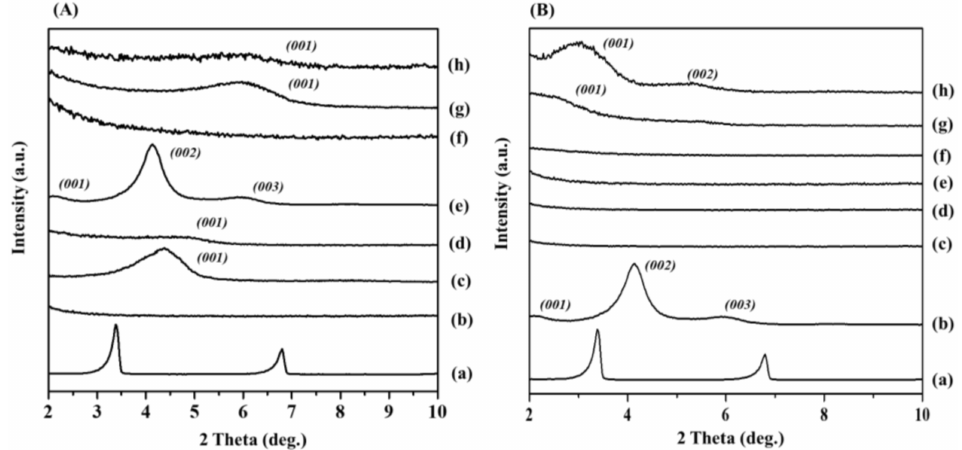
Figure 3. XRD patterns of: ( A ) ( a ) CTA, ( b ) pristine PP, ( c ) CTA-Mt, ( d ) 6 mass % CTA-Mt/PP nanocomposite, ( e ) CTA-Mica, ( f ) 6 mass % CTA-Mica/PP nanocomposite, ( g ) CTA-Ht, and ( h ) 6 mass % CTA-Ht/PP nanocomposite; ( B ) ( a ) CTA, ( b ) CTA-Mica, ( c ) pristine PP, ( d ) 1 mass % (depending on content of CTA-Mica/PP nanocomposite), ( e ) 3 mass %, ( f ) 6 mass %, ( g ) 9 mass %, and ( h ) 12 mass